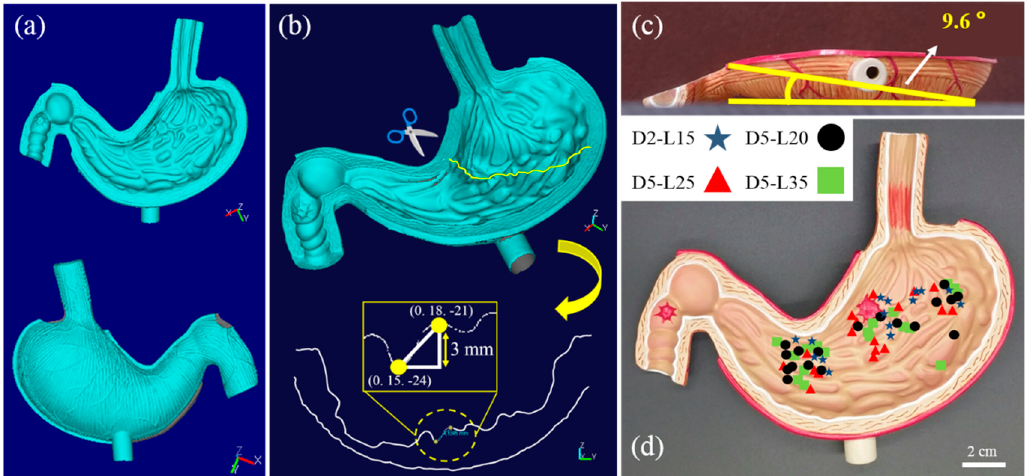
Figure 4. ( a ) Three-dimensional (3D) scanned images from the top and bottom of the gastric cancer model; ( b ) Sectioning and measurement of 3D location information for calculating wrinkle height in the gastric cancer model; ( c ) Angle of the slope of overall gastric cancer model obtained using the coordinate information; ( d ) Cessation location of magnetic actuation indicated for helical soft robots.